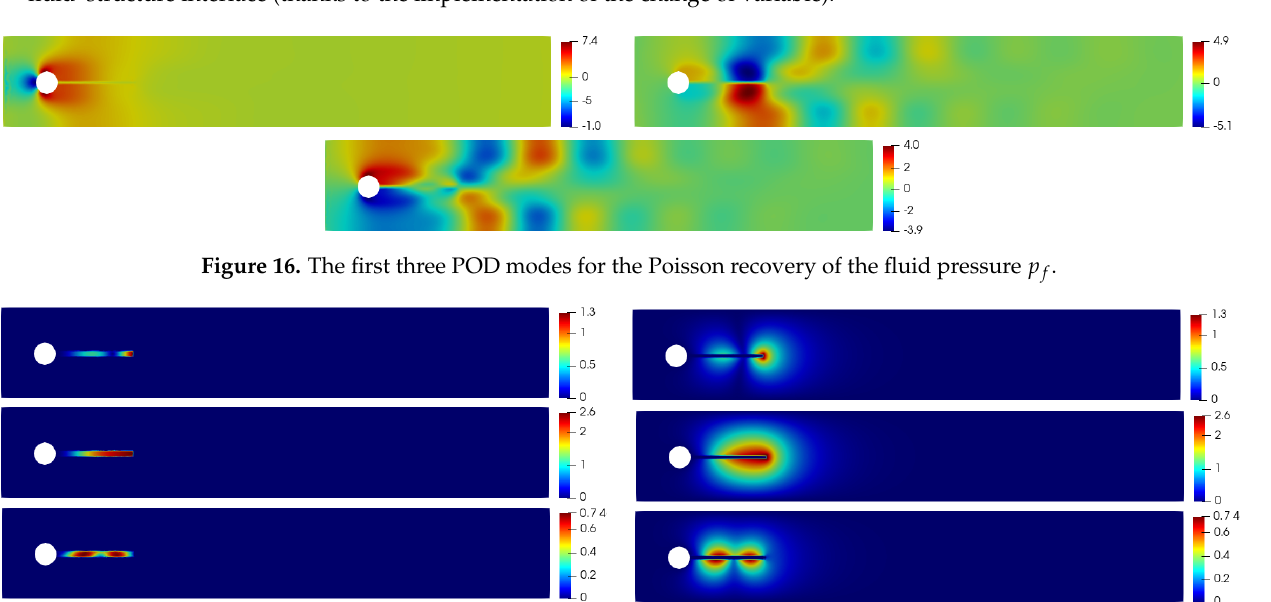
Figure 15. The first three POD modes for the fluid velocity change in variable z f (magnitude): notice how, for the partitioned approach, the magnitude of the modes is zero not only on the inlet boundary (thanks to the lifting function) but also on the fluid–structure interface (thanks to the implementation of the change of variable).